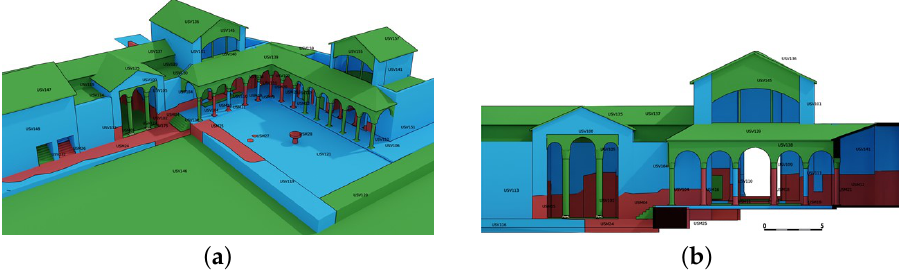
Figure 14. Proxy representation at eye bird point of view ( a ) or through a section ( b ). See colour chart in Table